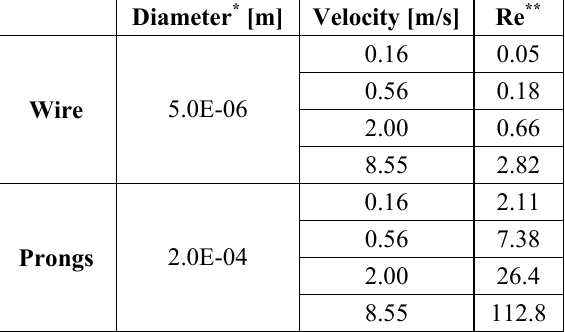
Table 1. Re values calculated for the wire and prongs.